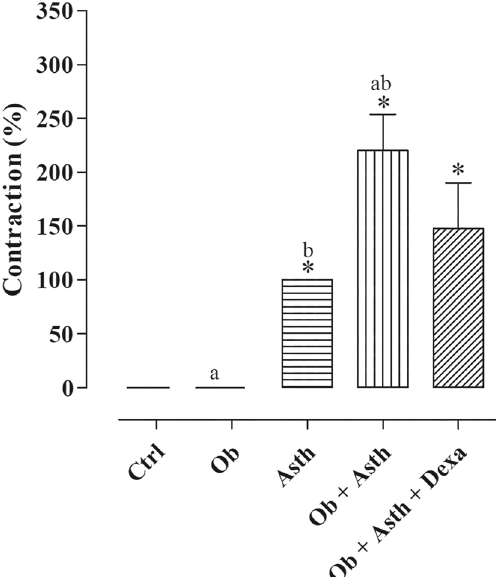
Figure 6. Effect of stimulation of rat trachea with 100 µg/ml OVA. Symbols and vertical bars represent the mean and the e.p.m., respectively. One-way ANOVA followed by Tukey’s posttest (n = 3–5). * p < 0.05 (Ctrl vs. Asth, Ob + Asth, and Ob + Asth + Dexa); a p < 0,05 (Ob vs. Ob + Asth); b p < 0,05 (Asth vs. Ob + Asth).